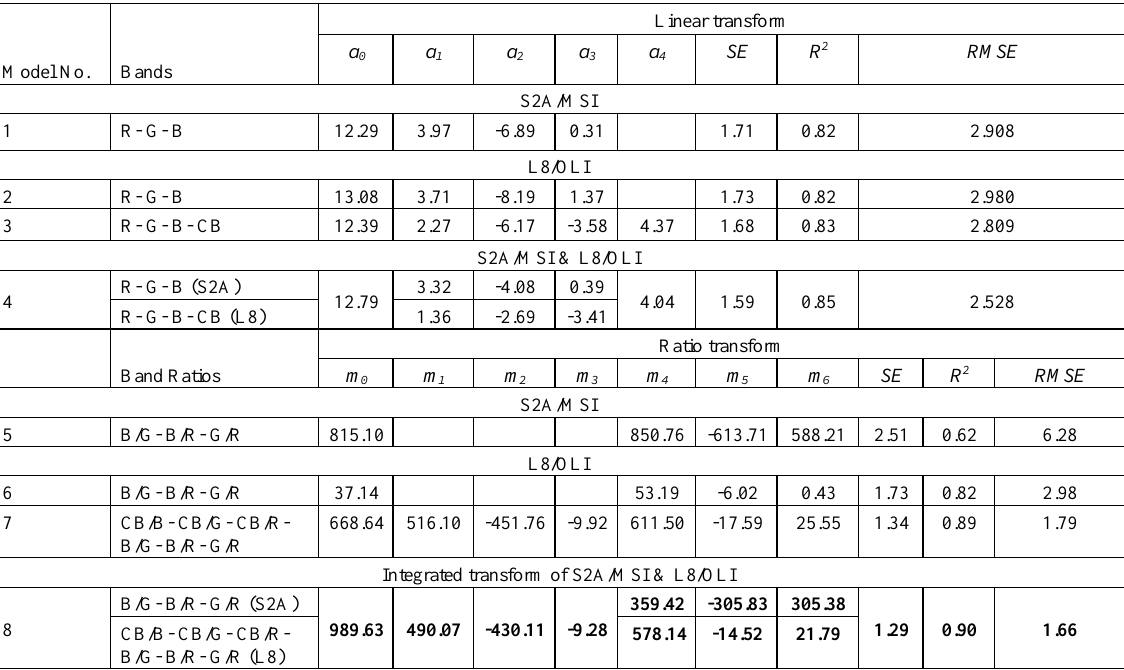
Table 1. Calculated parameters for all combination of bands for linear, ratios, and cross-sensor-based transform methods. (The numbers highlighted in bold format are the values obtained for optimum method)